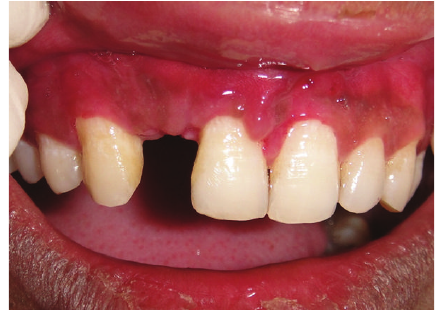
Figure 10: Edentulous area 3 weeks after graft placement.